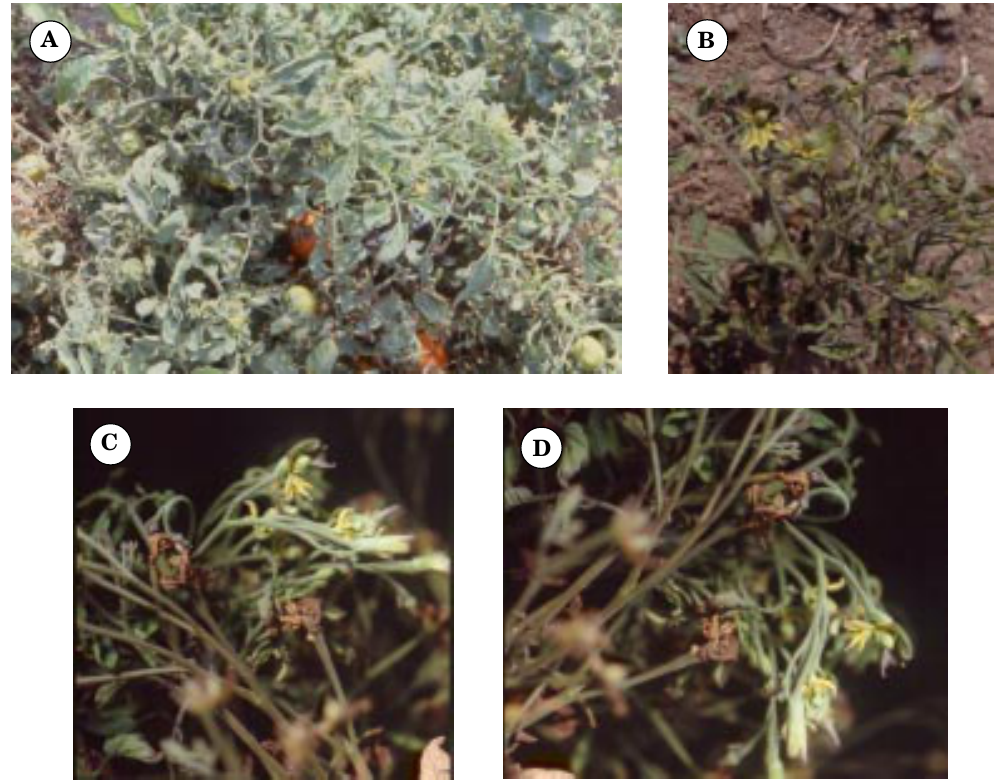
Fig. 1. Healthy (A) and phytoplasma infected tomato plant showing stunting (B), virescent flower (C), abnormally enlarged calices with completely joined sepals and abort of flowers